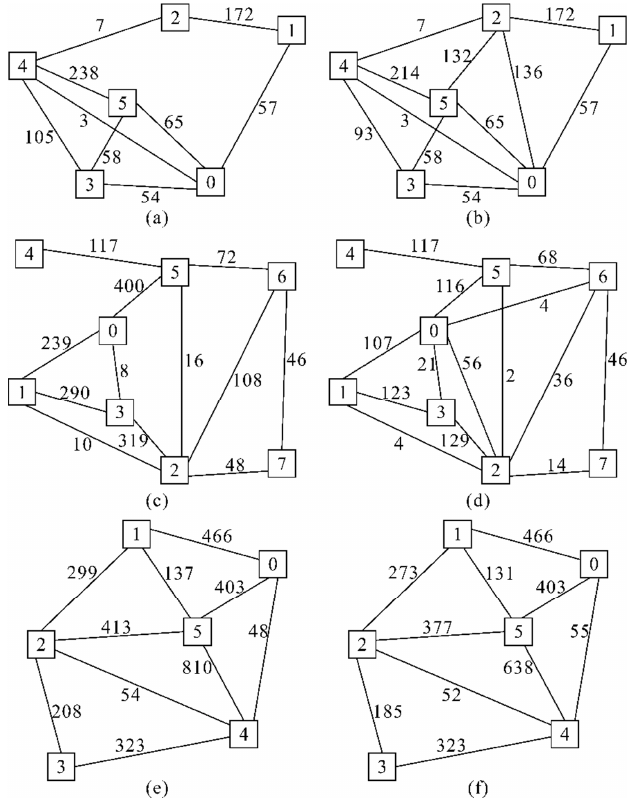
Figure 5. Results of image expansion in subclusters (represented as undirected graphs). The left column shows the expansion results of the traditional method, and the right column shows the ex- pansion results of the proposed method. The box represents a node in the undirected graph, and the number in the box represents the subcluster ID; the edge represents the connectivity between nodes, and the number attached to the edge represents the number of repeated images added be- tween nodes due to the expansion. ( a , b ) The dataset is Area 6, with a subcluster partition size of 1800; ( c , d ) the dataset is Area 5, with a subcluster division size of 1000; ( e , f ) the dataset is Area 7, with a subcluster division size of 5000.